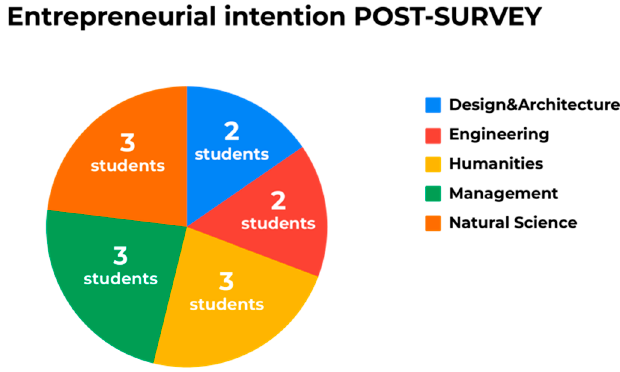
Figure 5. Post-course entrepreneurial intention (EI) composition (number of students).